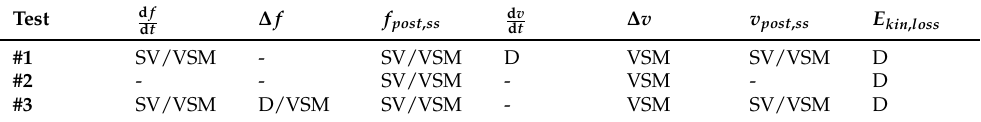
Table 6. Summary of the best-performing GFM controls with respect to the benchmark